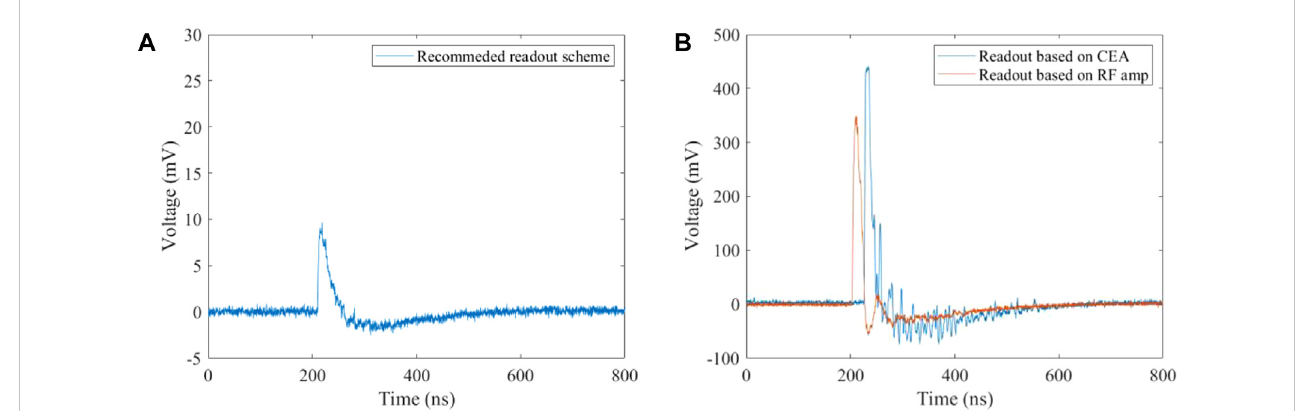
FIGURE 5 Typical timing waveforms in three experiments based on transformer-based readout (A) , CEA-based readout and RF ampli fi er-based readout (B) schemes.